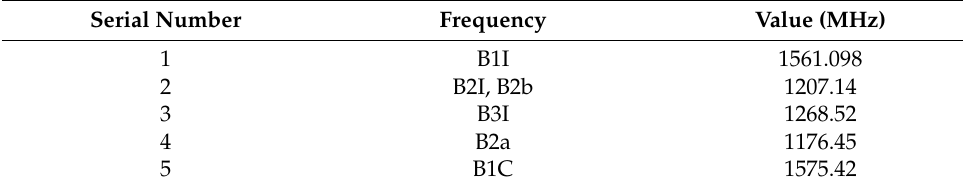
Table 1. List of existing frequency points of the BeiDou